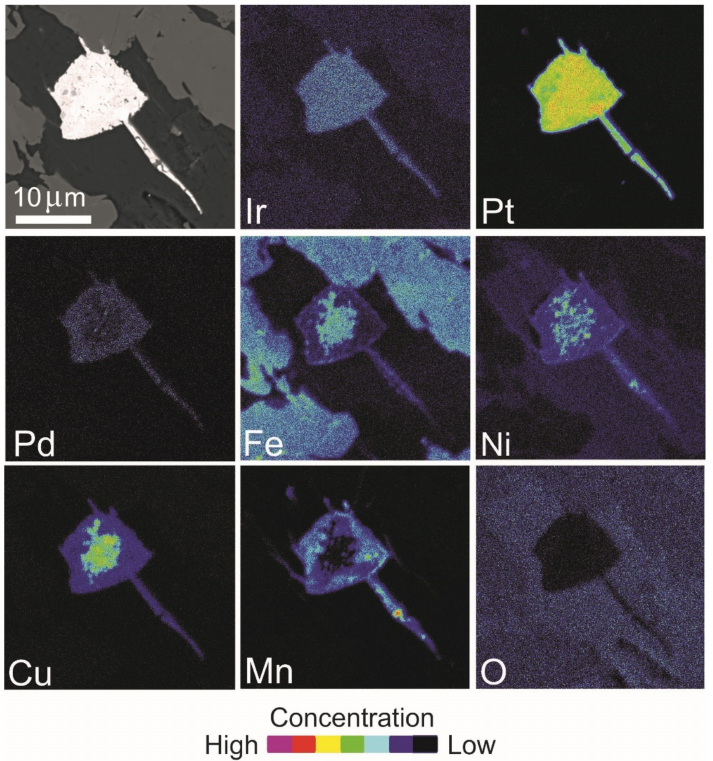
Figure 20. BSE image and X-ray elemental distribution maps of Ir, Pt, Pd, Fe, Ni, Cu, Mn and O in the Pt alloy of Figure